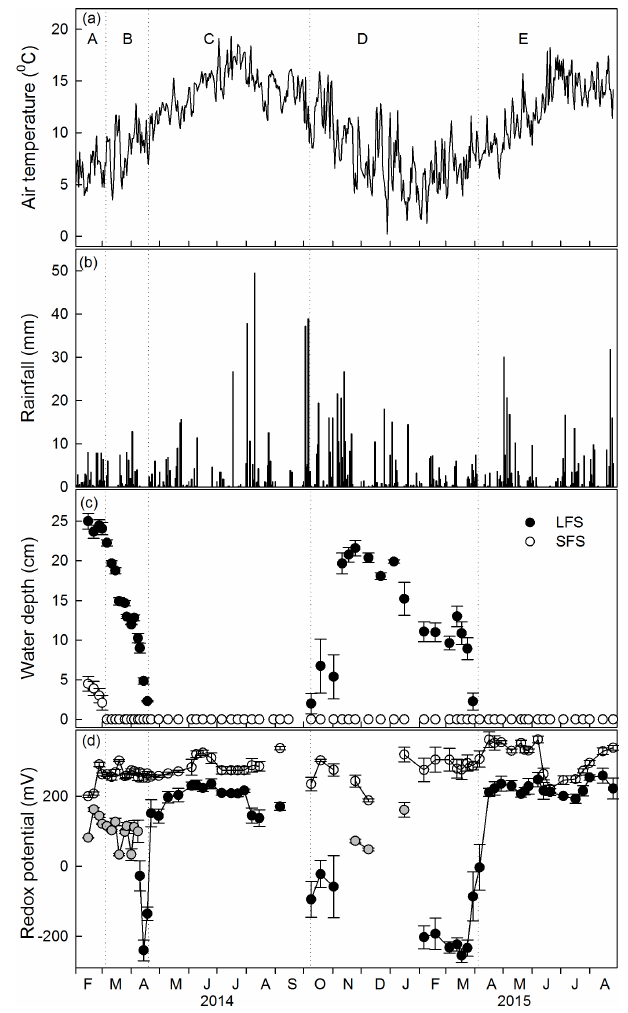
Figure 3. Variations in (a) daily air temperature, (b) daily rainfall, (c) average water depth above the soil surface and (d) redox poten- tial at the study sites. Open circles represent redox values from the ground surface of the SFS, black filled circles represent values from the soil surface of the LFS and grey filled circles show values from the water surface while the LFS was flooded to greater than 10cm depth. Period A: LFS and SFS flooding; period B: LFS flooding; period C: neither LFS nor SFS flooding; period D: LFS flooding; period E: neither LFS nor SFS flooding. Thus, there was no